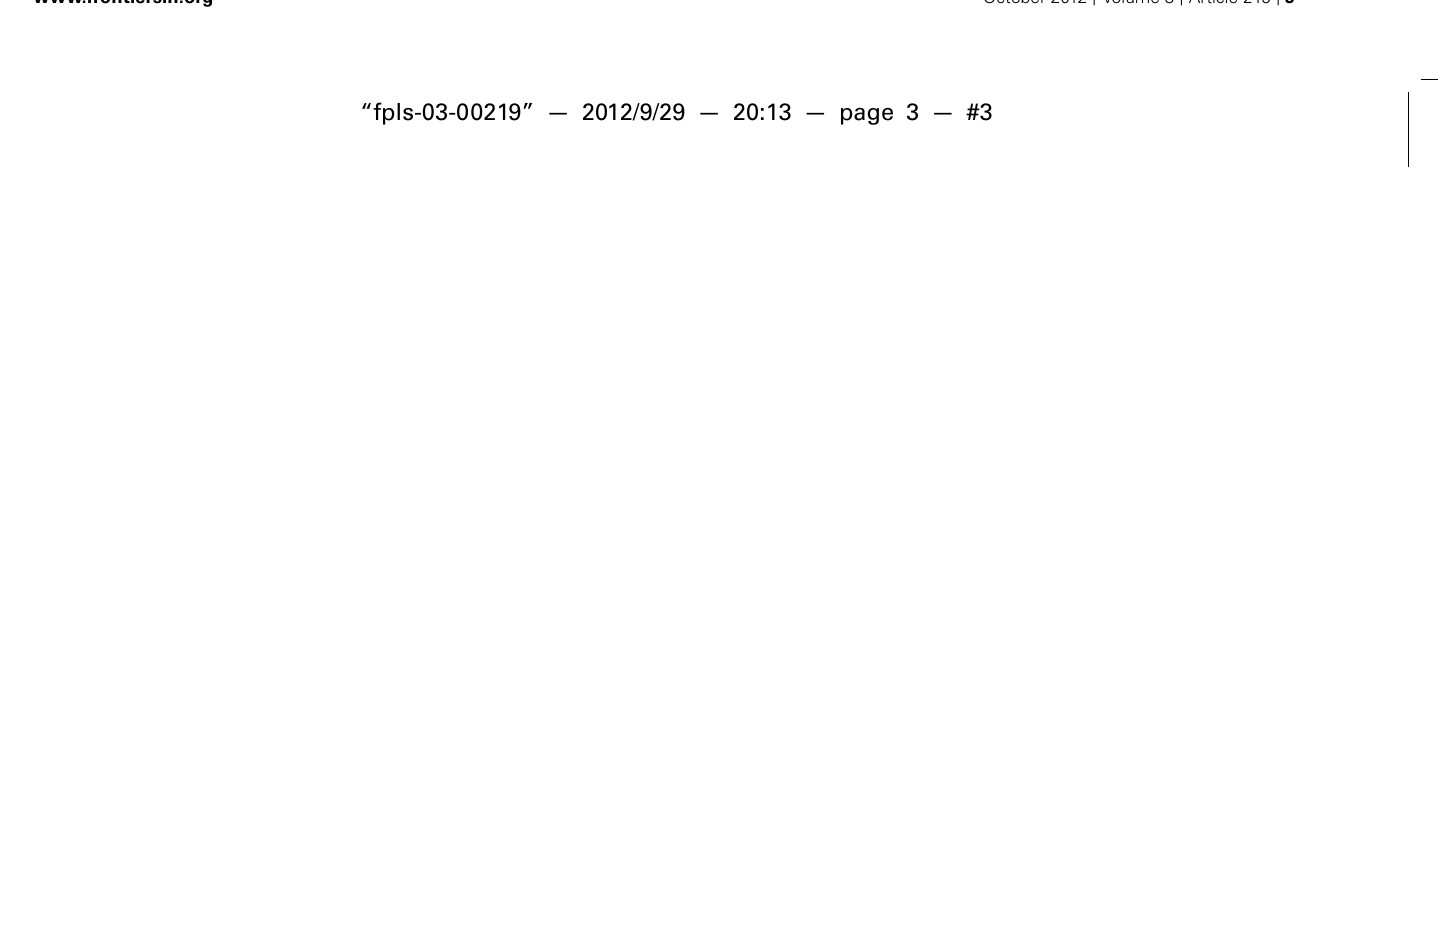
FIGURE 2 |A model in PCs for PIN1 polarization to the lobe regions of PCs via a ROP signaling mechanism. ROP2 is activated by extracellular auxin in the lobe region.The activated ROP2–RIC4 pathway leads to the inhibition of PIN1 internalization through RIC4-dependent cortical F-actin, leading to PIN1 polarization at the lobe.The PIN1-based export of auxin leads to further ROP2 activation for completion of this feed-forward cycle. Recent data (Nagawa etal., 2012) indicates that the activated ROP2–RIC4 pathway has a role in the promotion of endosomal trafficking from early endosomes to